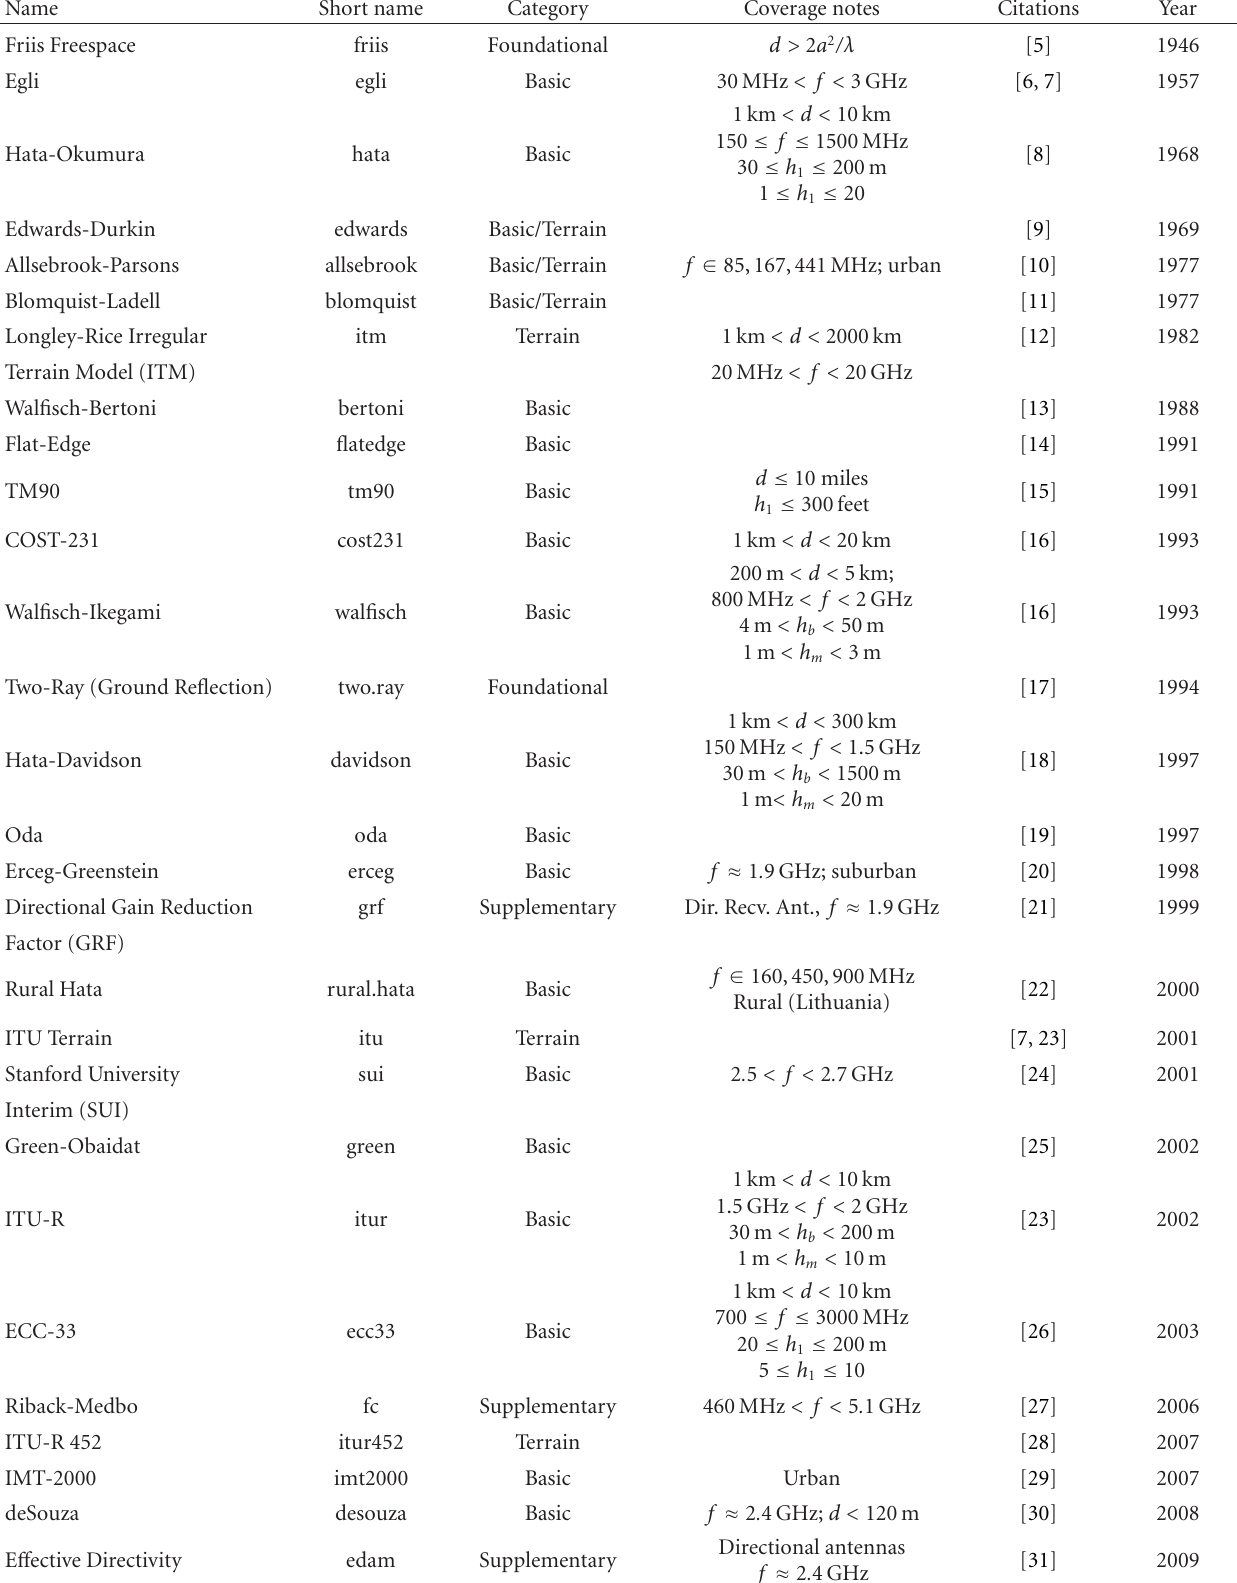
Table 1: Models studied along with their categorization, required input, coverage remarks, relevant citations, and year of (initial)